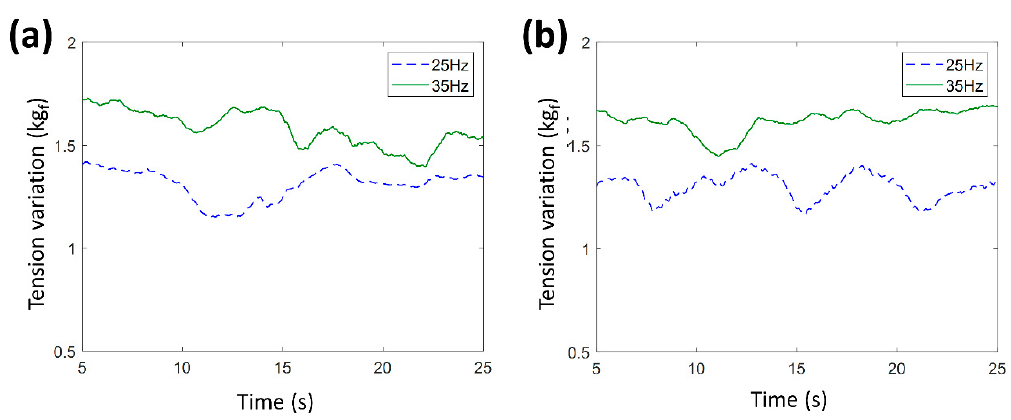
Figure 10. Measured tension in the substrate for blower frequencies of 25 Hz and 35 Hz at operating velocities of 10 m/min ( a ) and 15 m/min ( b ).